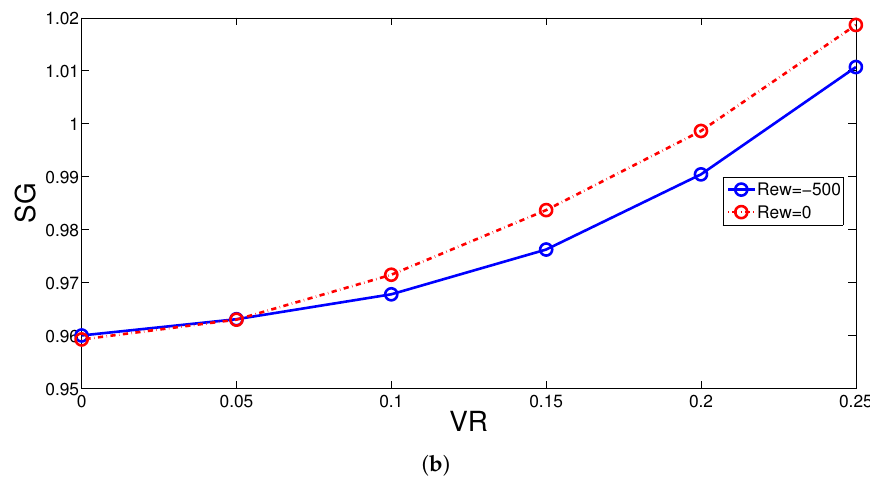
Figure 10. Impacts of rotational Re on the variation of EG for stationary (VR = 0) and moving wall (VR = 0.25) cases ( a ) and impacts of VR on EG for rotating (Rew = − 500) and non-rotating CC cases (Rew = 0) CC cases ( b ) (Ha = 5, Mx = − 1).